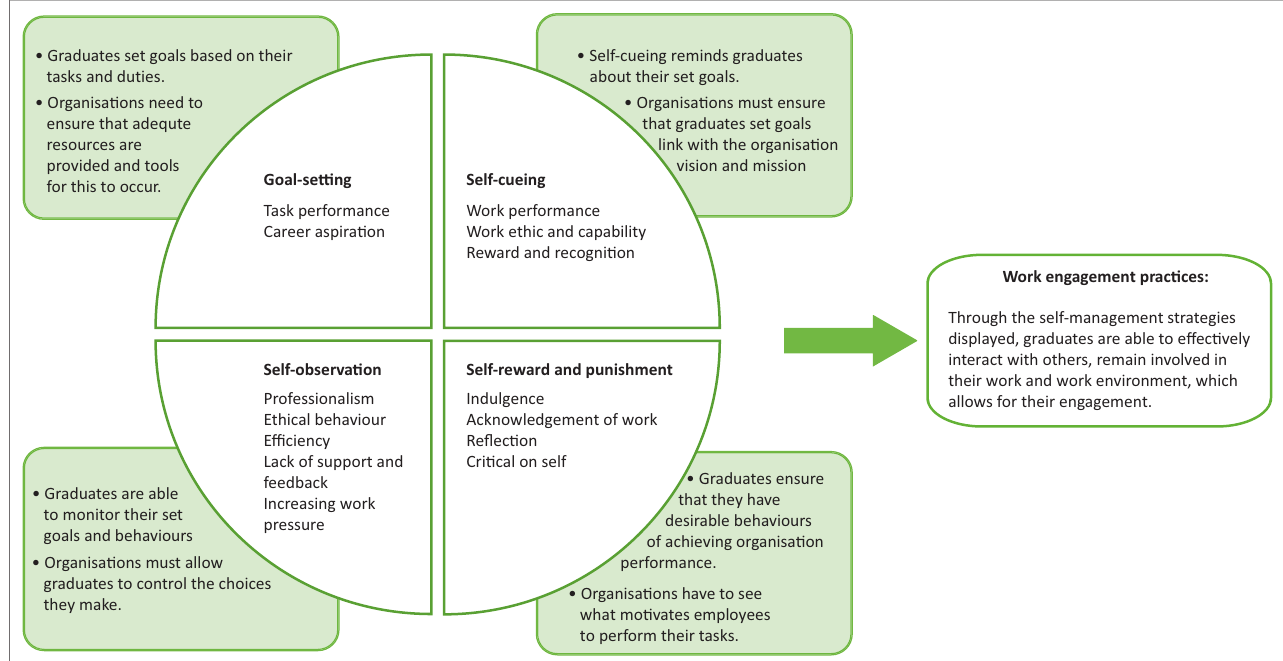
FIGURE 1: A model of self-management strategies to enhance work